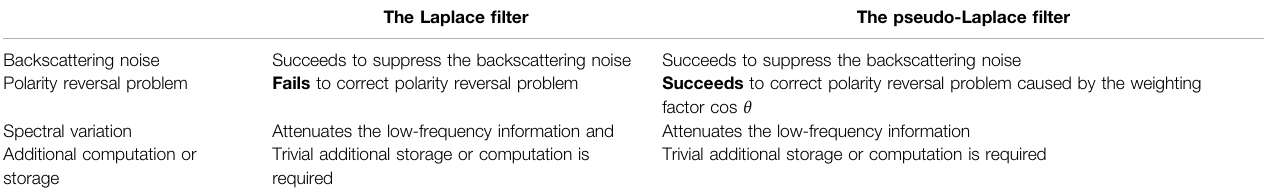
TABLE 1 | The comparison between the Laplace fi lter and pseudo-Laplace fi lter. The Laplace fi lter The pseudo-Laplace fi